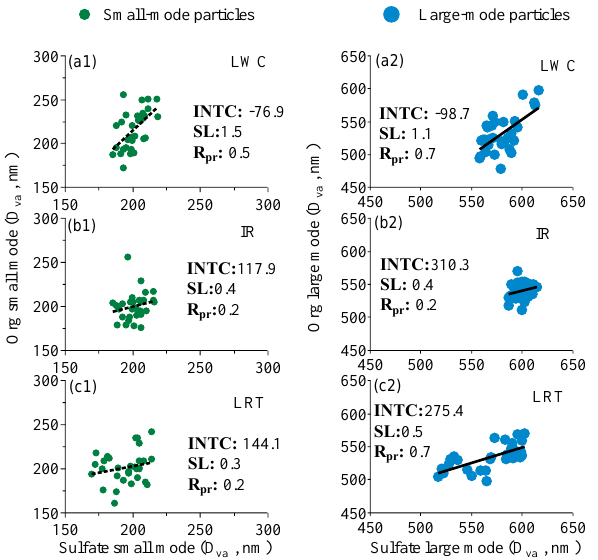
Figure 5. Scatter plots and linear least-squares fits of mass-mode diameters of organics and sulfate during the three different types of episodes. (a1, a2) Small and large mass-mode diameter of organics against sulfate during LWC episodes, (b1, b2) small and large mass- mode diameter of organics against sulfate during IR episodes, and (c1, c2) small and large mass-mode diameter of organics against sulfate during LRT episodes. INTC stands for intercept, SL stands for slope and R pr stands for Pearson’s R .